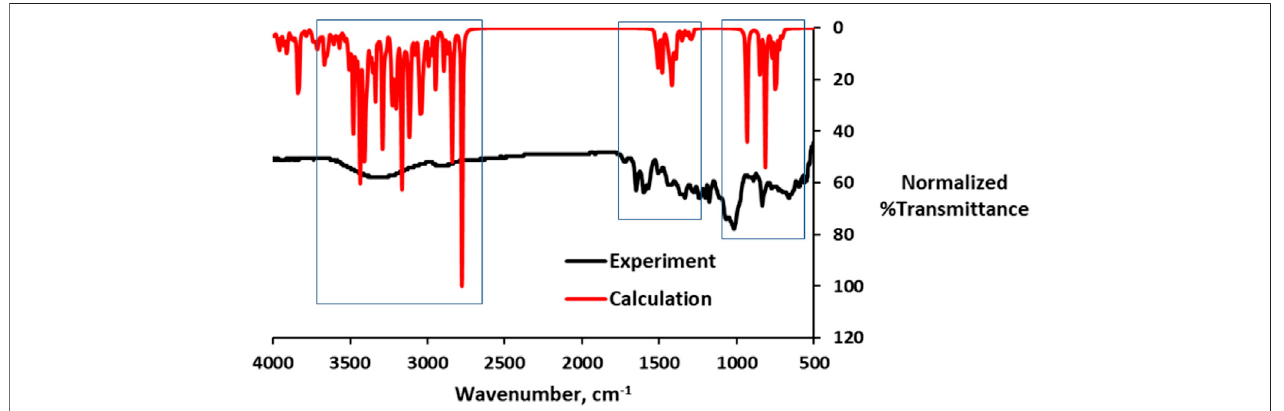
FIGURE 2 | Overlay of the calculated and experimental IR data (red (cid:1) computed and black (cid:1) experiment).